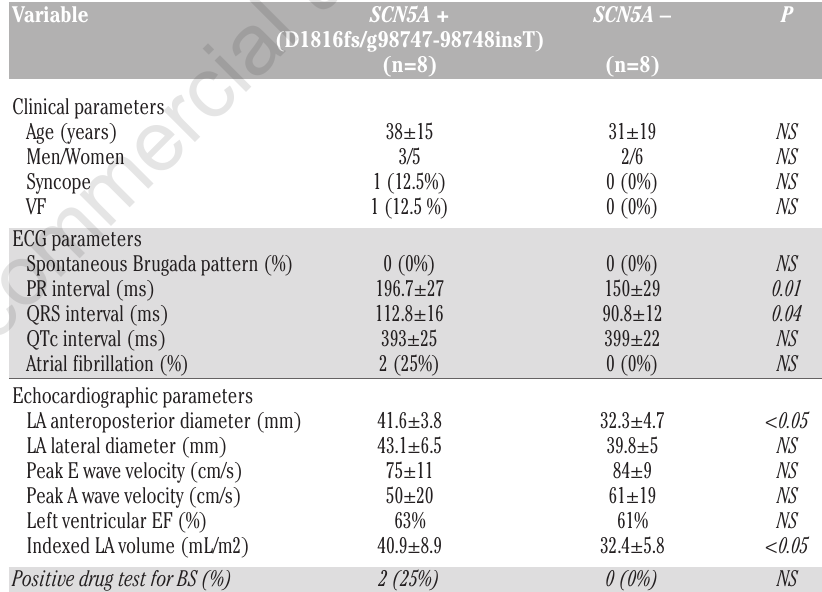
Table 1. Statistical comparison between the two groups analysing electrocardiographic, echocardiographic and flecainide test parameters.